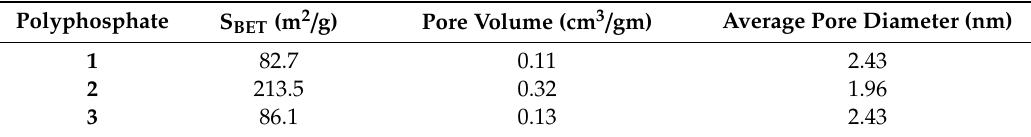
Table 3. Porosity properties of 1–3